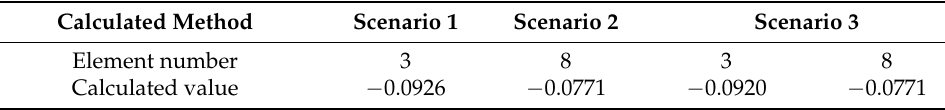
Table 2. Calculation results of equivalent damage.